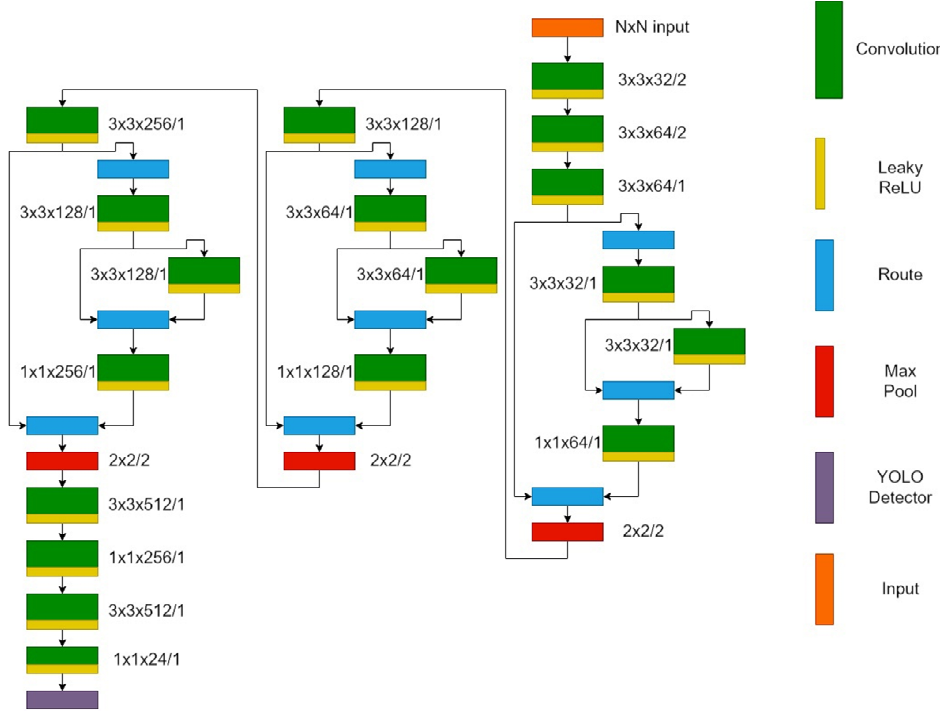
Figure 7. YOLOv4-tiny architecture.